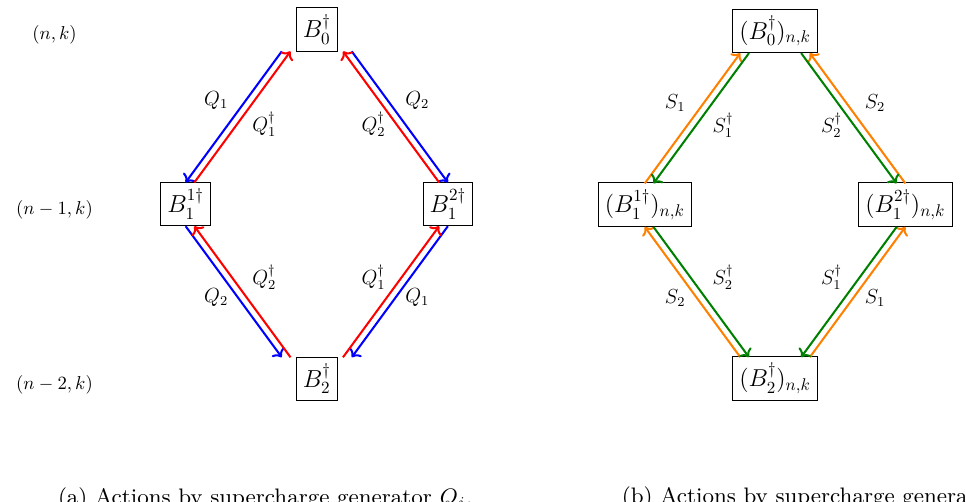
Figure 1. The blocks as an N = 2 vector multiplet. The blue arrows are actions by Q i while the red arrows are the actions by Q † . Similarly the orange arrows are the actions of S i are the actions by S † . The ˜ Q supercharges are not shown in this diagram, which will only differ from i i this one by changing the k levels, which corresponds to the derivative operator d supercharges Q will change the level by 1 while the supercharges of S kind do not change the levels. i